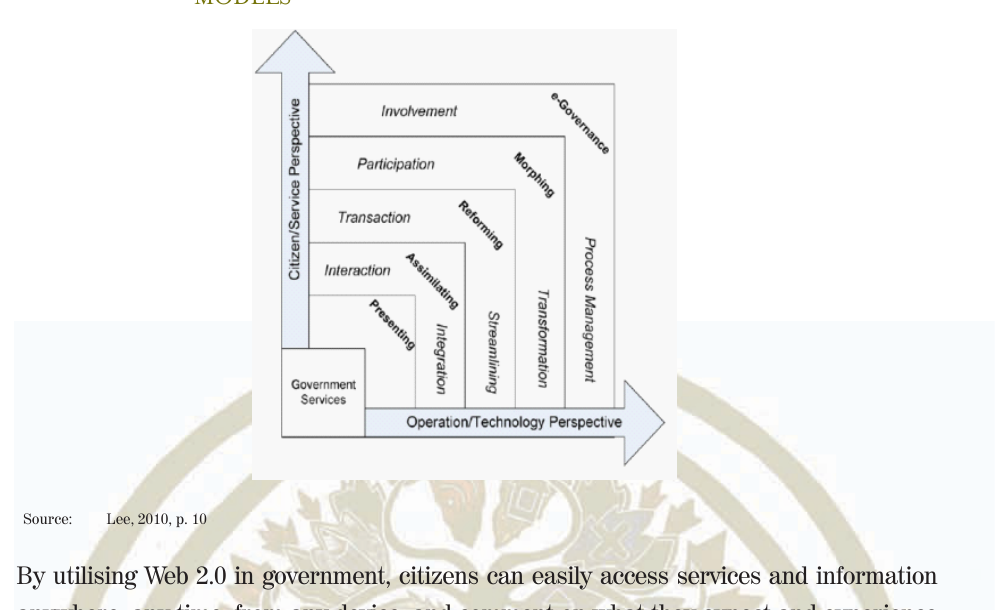
FIGURE 1: A COMMON FRAME OF REFERENCE FOR E-GOVERNMENT STAGE